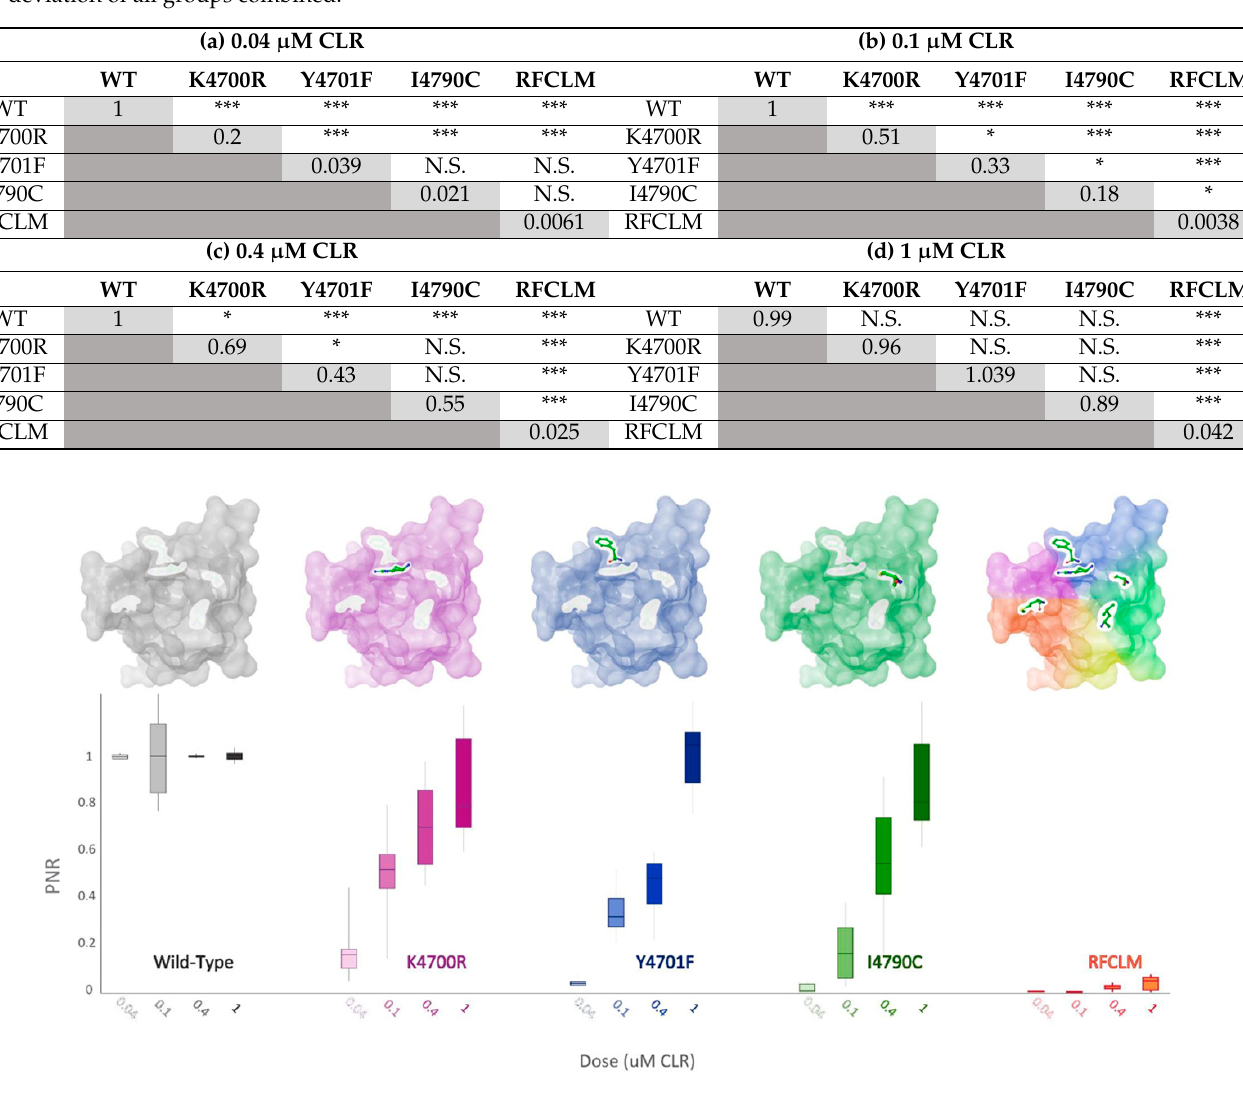
Table 2. Comparison of the responses of PxRyR sequence variants to discriminating CLR concentrations ( a – d ). Grey boxes list the average response of that construct (PNR). White boxes display indices of significance, based on LSD comparisons of amplitude between the variants. N.S. = Not Significant; * = p < 0.05; *** = p < 0.001. The least significant difference (LSD) consists of a pairwise comparison of mean average response amplitude between the constructs compared to the standard deviation of all groups combined.